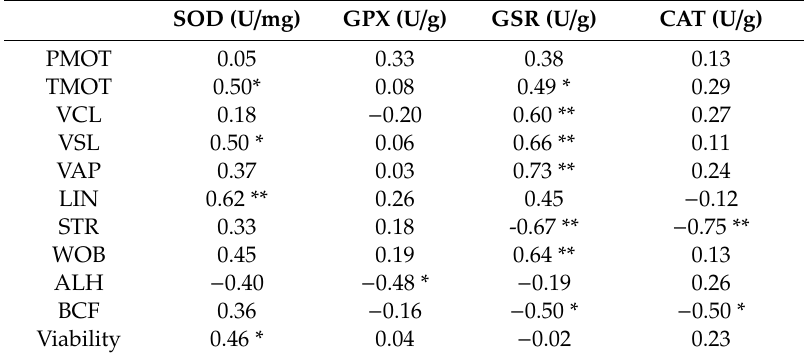
Table 3. Pearson correlation coe ffi cients between specific enzyme activities and post-thawed sperm quality parameters ( n = 16).